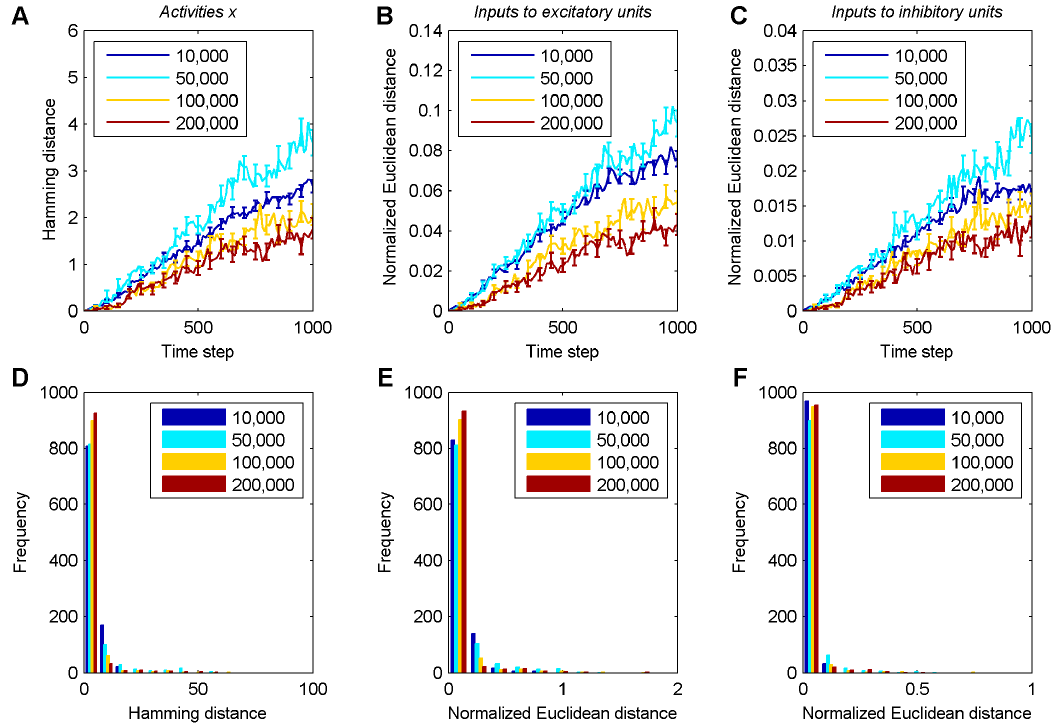
Figure 6. Perturbation analysis of neuron activities. The legend shows the starting times of perturbations. A Averaged Hamming distance between neuron activities of the perturbed and unperturbed networks over 1,000 simulations for 1,000 time steps. Only every tenth time step is plotted. Error bars indicate standard errors of the mean in A–C and are given every 50th time step. B Averaged normalized Euclidean distance of excitatory neuron inputs over 1,000 simulations for 1,000 time steps. C Averaged normalized Euclidean distance of inhibitory neuron inputs over 1,000 simulations for 1,000 time steps. D – F Histograms of Hamming distances and normalized Euclidean distances at 1,000th time step in A–C, respectively.